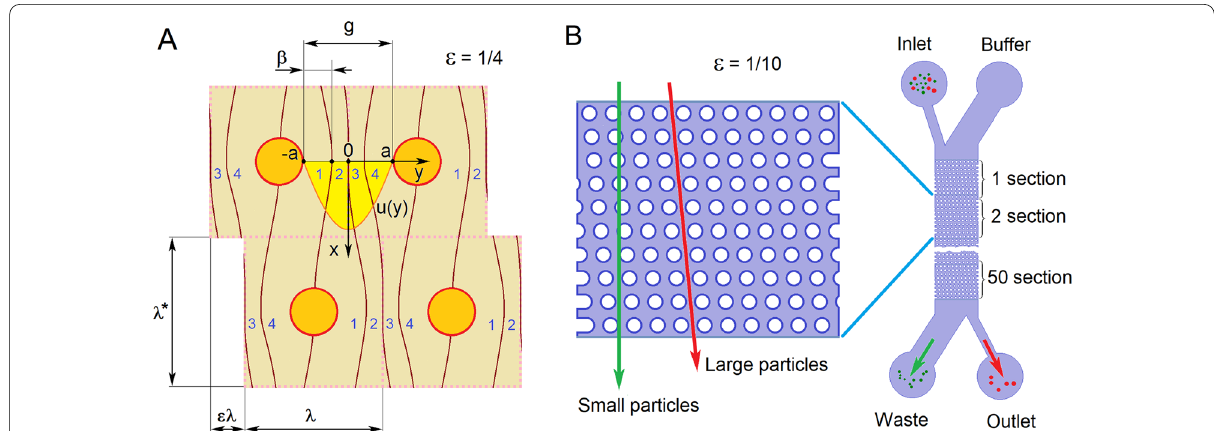
Fig. 1 Deterministic lateral displacement arrays. A Top view of the middle section of a typical sorting device. The pattern is laid out with rectangular mosaic tiles of size λ λ * . B Scheme of the experimental device for the separation of large particles ×